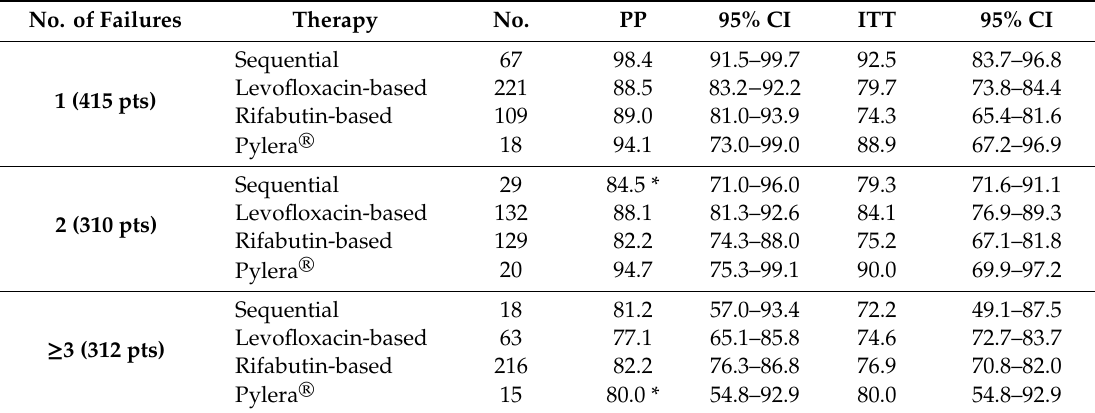
Table 4. Cure rates accordingly to previous therapeutic